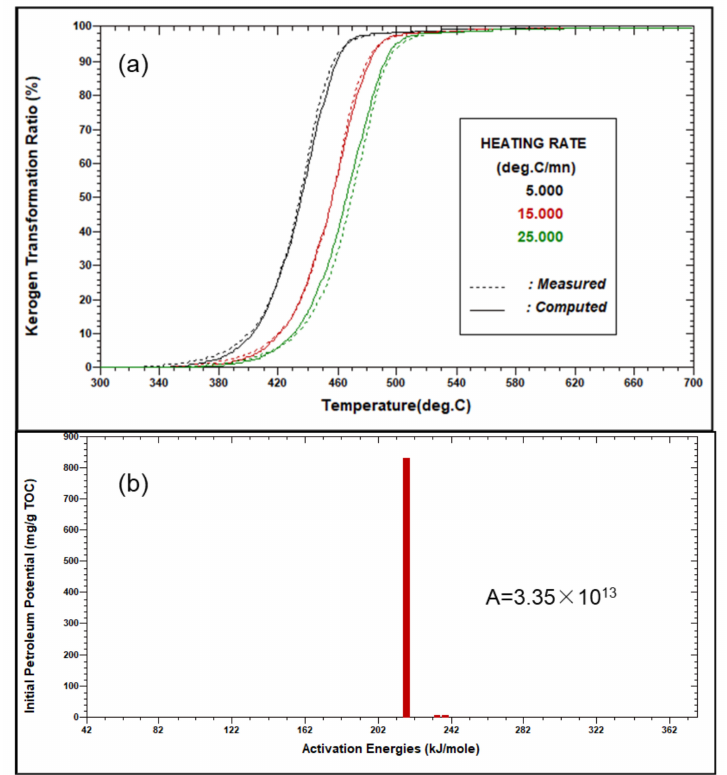
Figure 5. Activation energy distribution of Tasmanite oil shale Aus-2. ( a ) Kerogen transformation ratio vs Temperature comparison with different heating rate of 5 ◦ C, 15 ◦ C and 25 ◦ C per minite. ( b ) The activation energy frequency distribution of oil shale